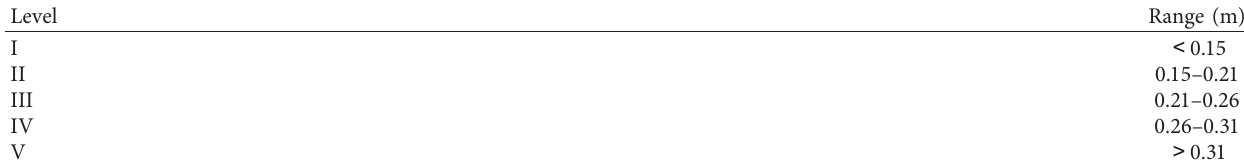
Table 13: The rating of average overbreak.